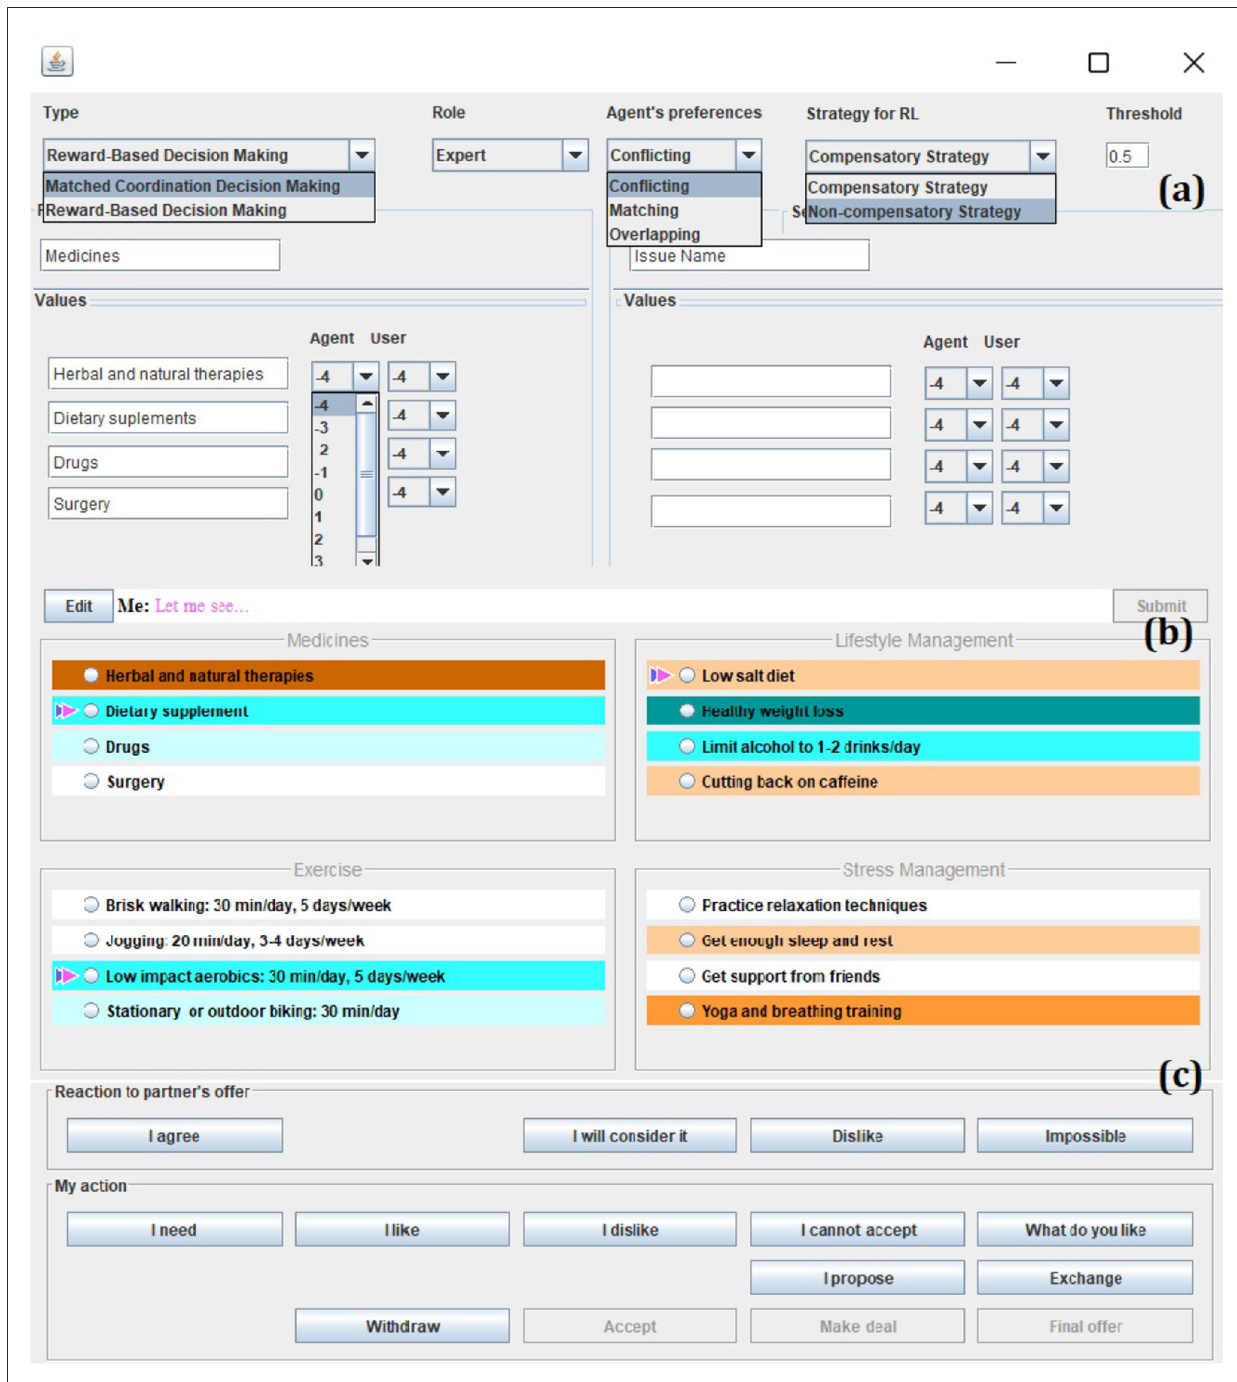
FIGURE2 Authoring content and setting a preference profile for a “hypertension” scenario. From top to bottom: (a) menu to author negotiation values, setting a preference profile and negotiation strategy selection either by an expert or user; (b) resulted authored or automatically generated preference profile; and (c) an action selection